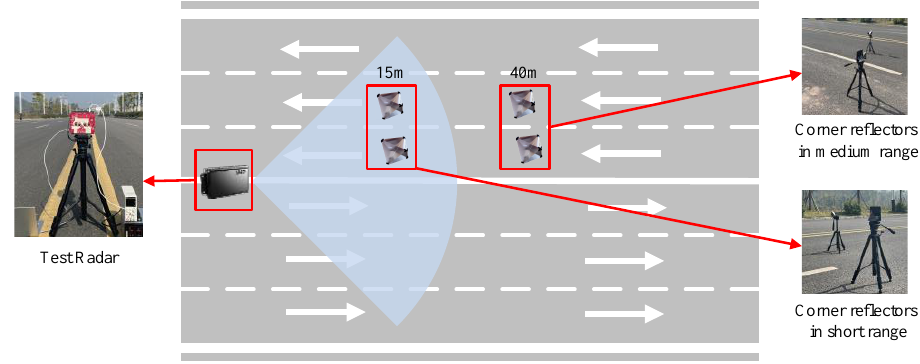
Figure 15. Photograph of radar deployment and test scene.